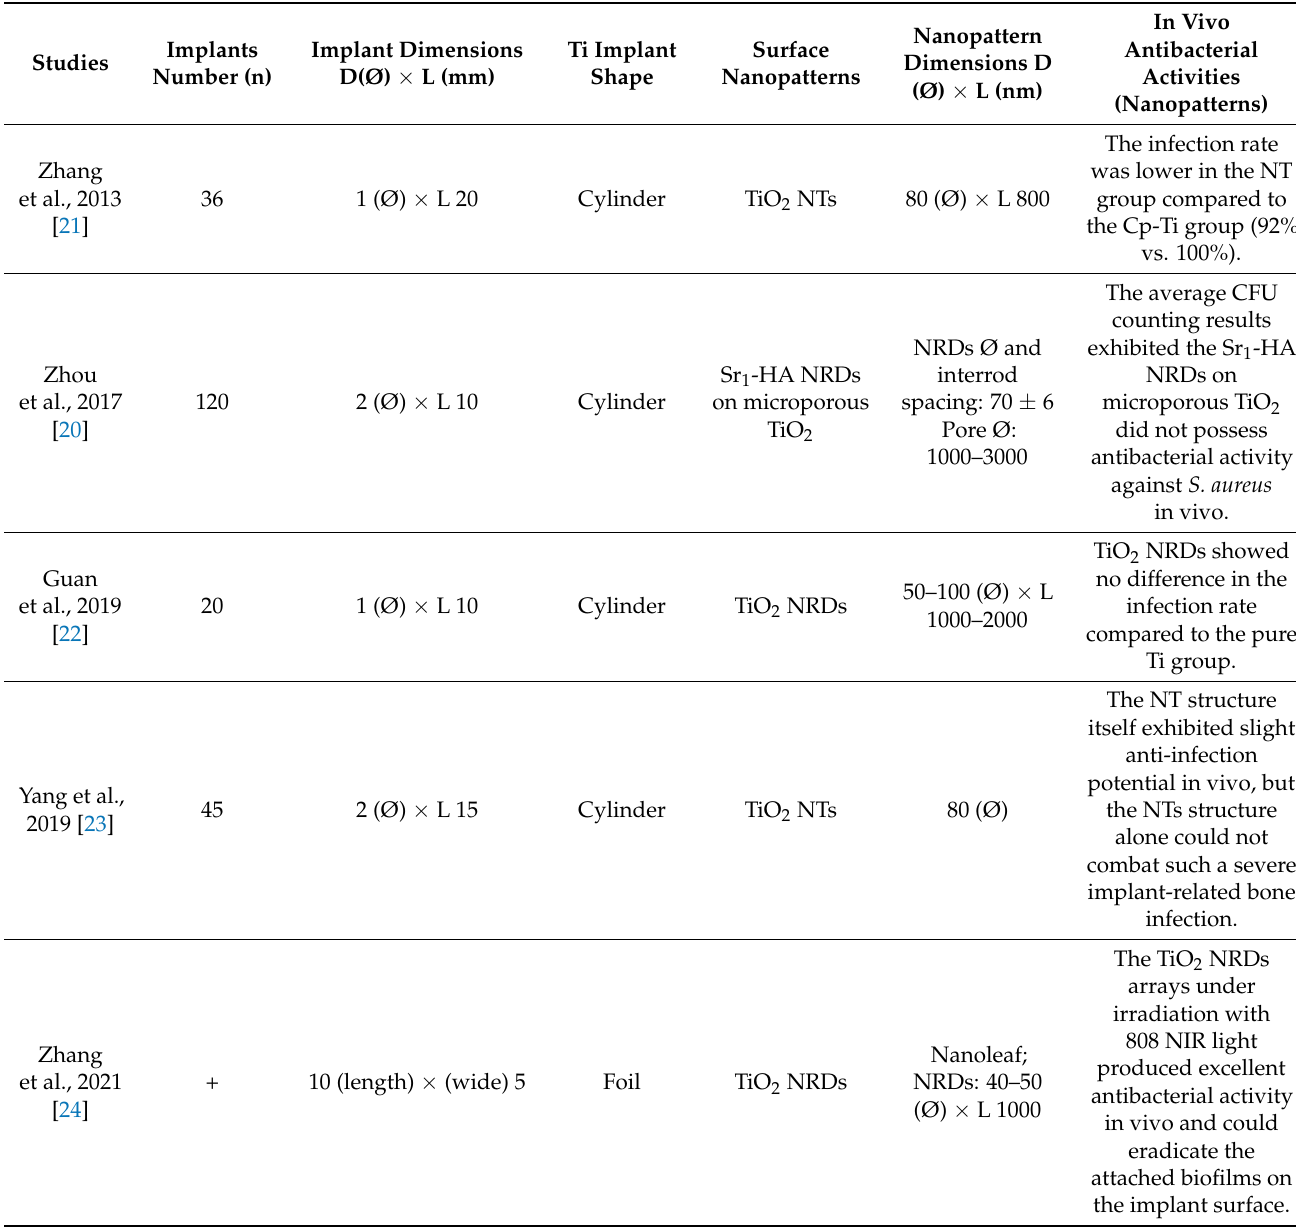
Table 2. Implant characteristics and in vivo antibacterial activities